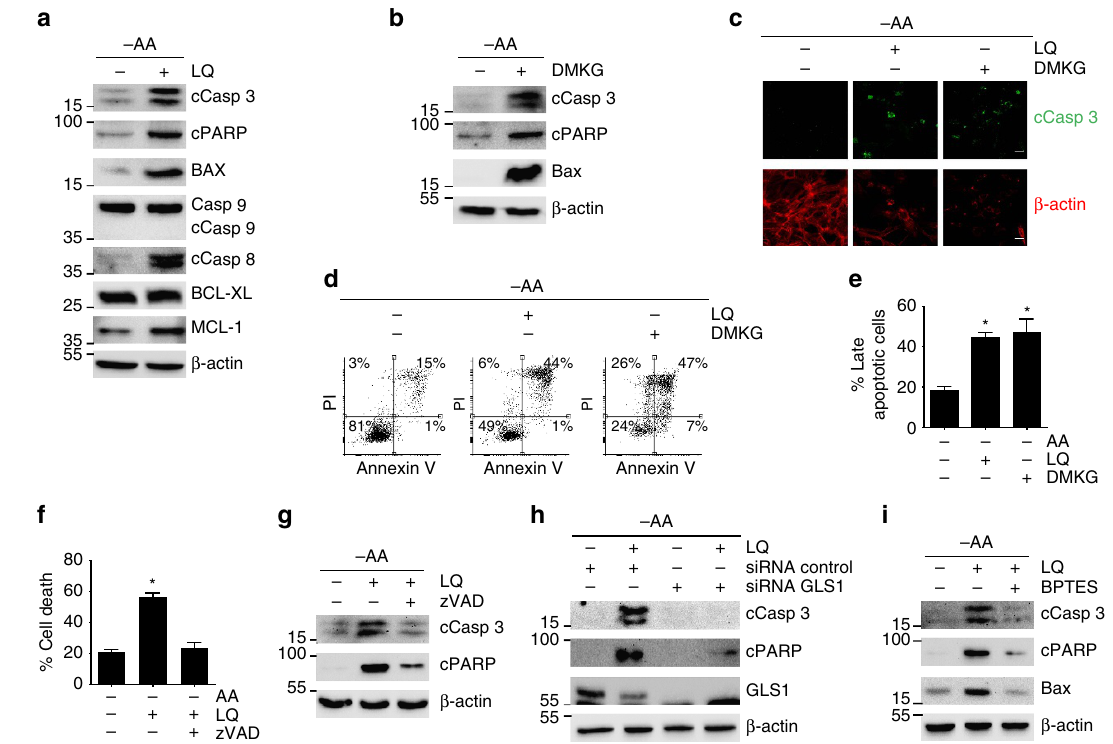
Figure 2 | Glutaminolysis activation during amino acid restriction induced apoptosis. ( a , b ) U2OS cells were starved for amino acid either in the presence or the absence of LQ ( a ) or DMKG (2mM) ( b ). The level of the pro-apoptotic proteins (caspase 3, PARP, BAX, Caspase 8 and caspase 9) and anti-apoptotic member of the Bcl-2 family (Bcl-XL and MCL-1) were determined by western blot for U2OS cells treated as indicated. The scale bar represents 20 m m. ( c ) Immunofluorescence analysis of cleaved caspase 3 and actin filaments are shown for LQ-treated and DMKG-treated cells upon amino acid starvation after 72h in U2OS cells. ( d ) Flow cytometry analysis of annexin V/PI staining of U2OS cells treated with LQ or DMKG as indicated. ( e ) Quantification of late apoptosis (annexin V/PI-positive cells) for the indicated conditions in U2OS cells. ( f , g ) Effect of the inhibition of apoptosis using zVAD-FMK (1 m M) on the percentage of cell death ( f ) and apoptotic markers ( g ) in LQ-treated U2OS cells. ( h , i ) Western blot analysis of apoptotic markers upon GLS1 silencing using siRNA ( h ) or upon GLS inhibition using BPTES ( i ) in LQ-treated U2OS cells. Graphs show mean values ± s.e.m. ( n ¼ 3). * P o 0.05 (Anova post hoc